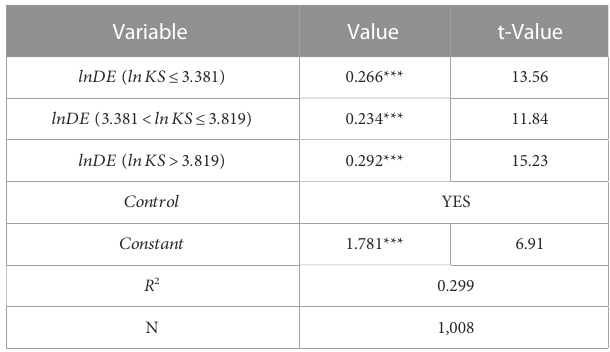
TABLE 8 Threshold model results.